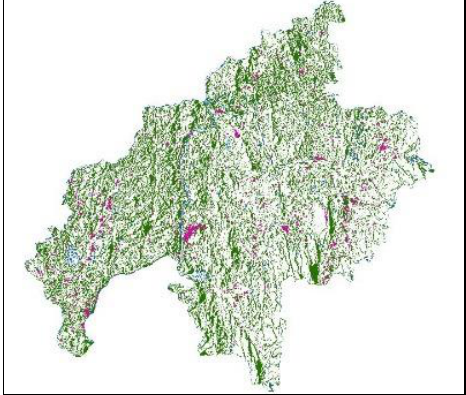
Figure 6. The results of residential area extraction